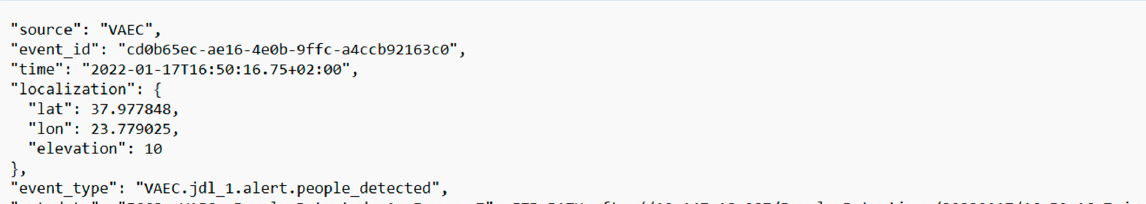
Figure 5. Crucial information associated with the person detection alert sent from the Application Service of DECIoT to Apache Kafka.